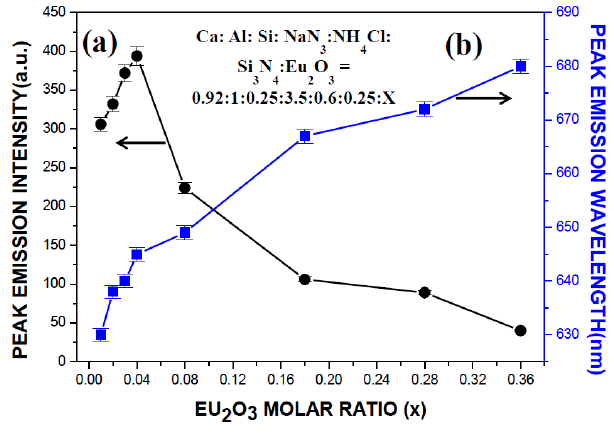
Figure 10. Dependence of ( a ) peak emission intensity and ( b ) peak emission wavelength on the Eu 2 O 3 molar ratio, x